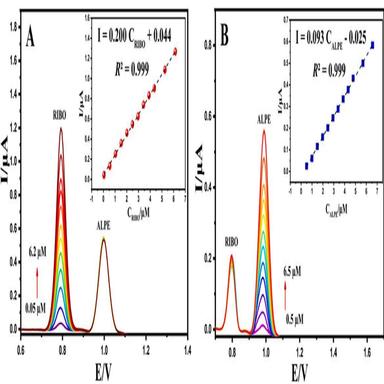
(A) DPVs of RIBO in the concentration range from 0.05 Мm to 6.2 μM in presence of constant concentration 6 μM of ALPE in PBS; inset: the corresponding calibration curve for RIBO. (B) DPVs of ALPE in the concentration range from 0.5 μM to 6.5 μM in presence of constant concentration 0.5 μM of RIBO in PBS; inset: the corresponding calibration curve for ALPE.